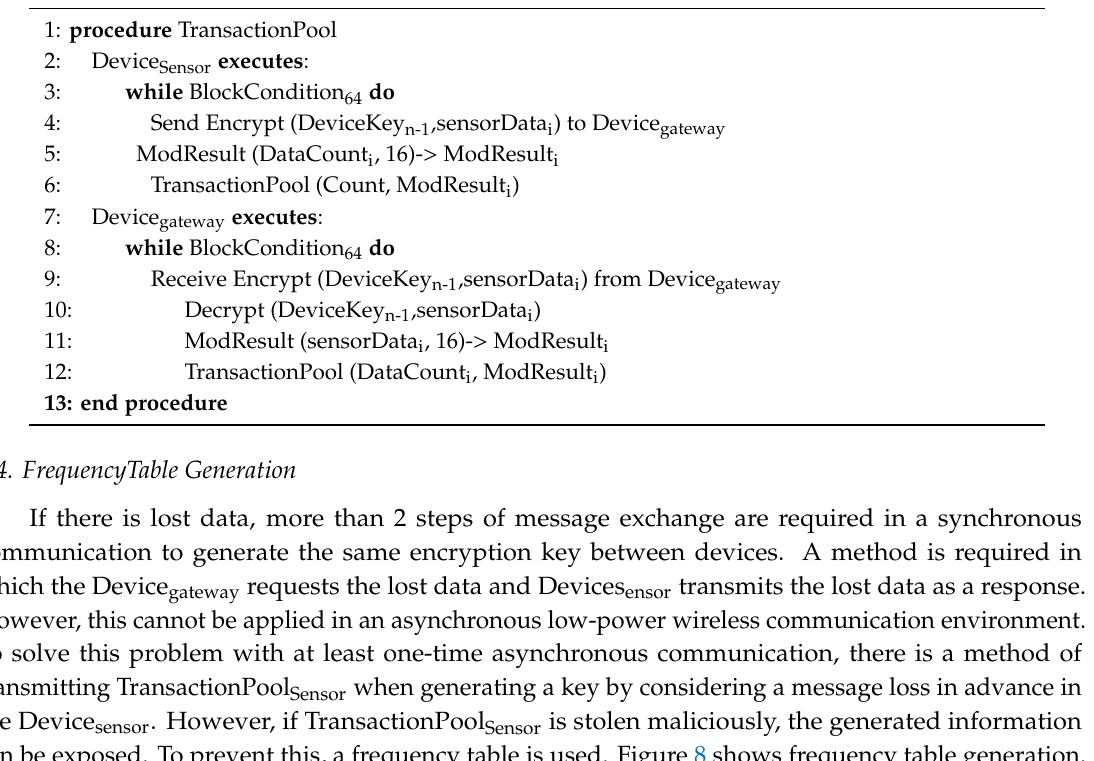
Algorithm 1 . TransactionPool